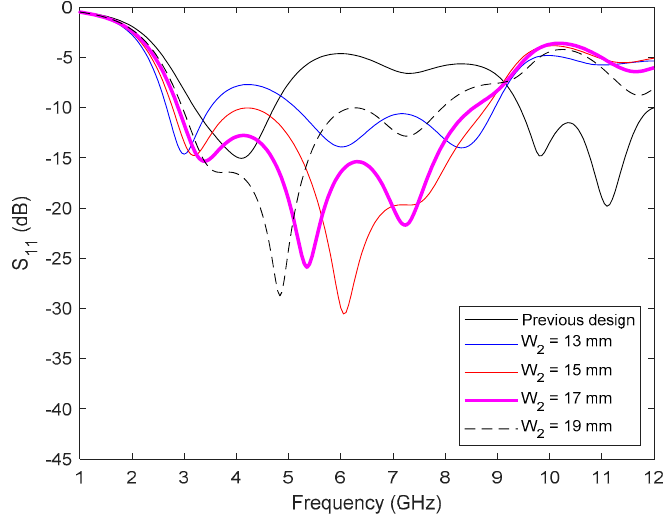
Figure 3. Antenna results for different values of (cid:1849) (cid:2870)